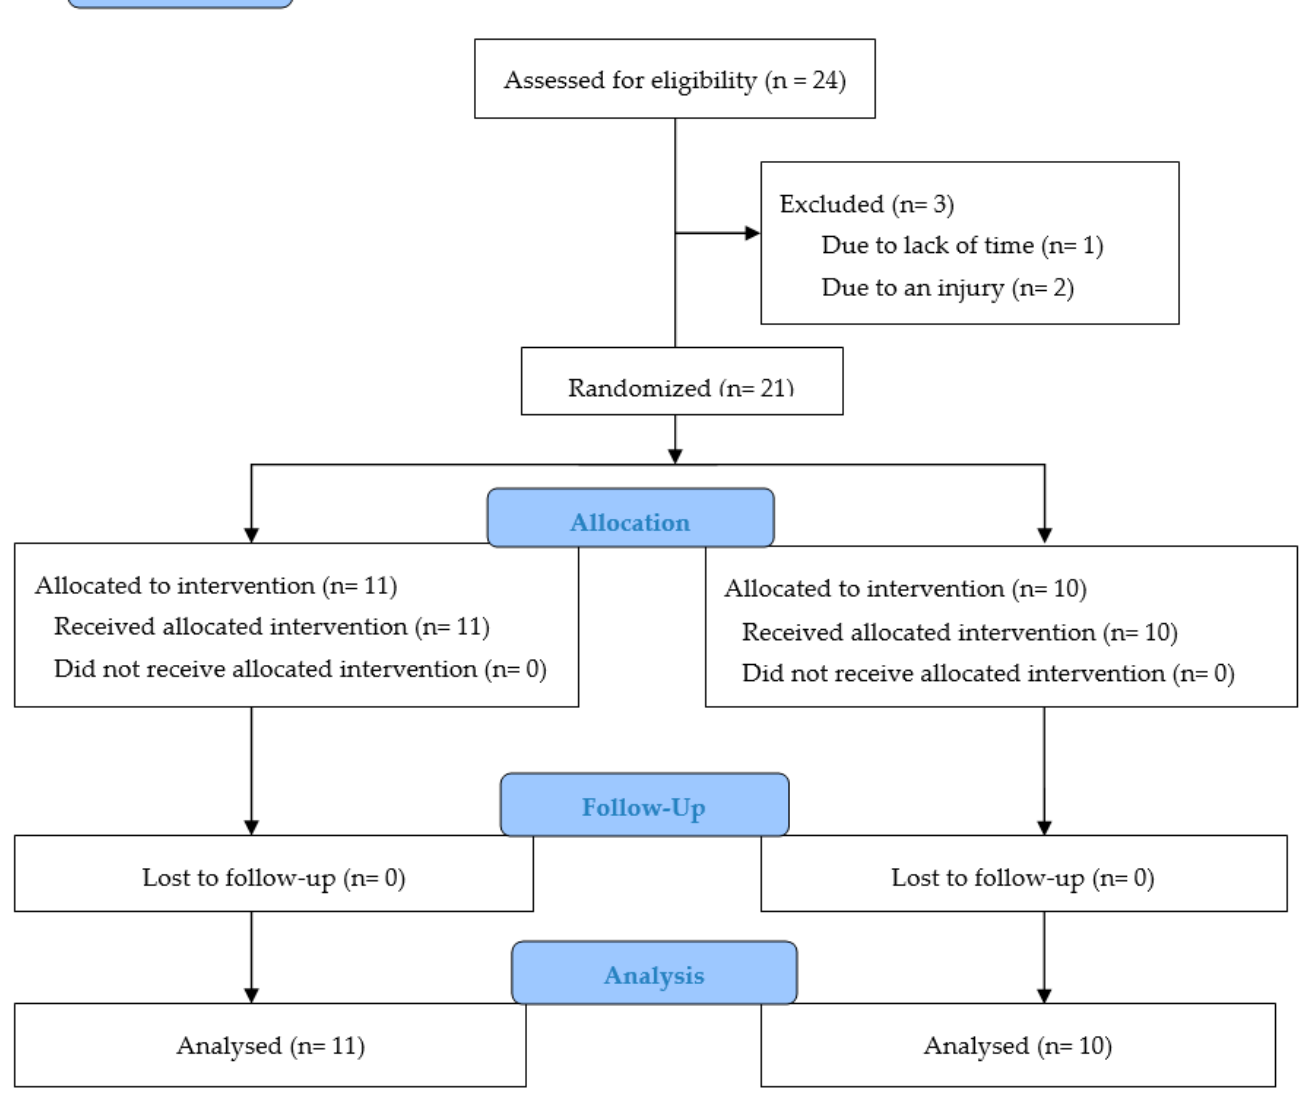
Figure 2. CONSORT 2010 flow diagram.